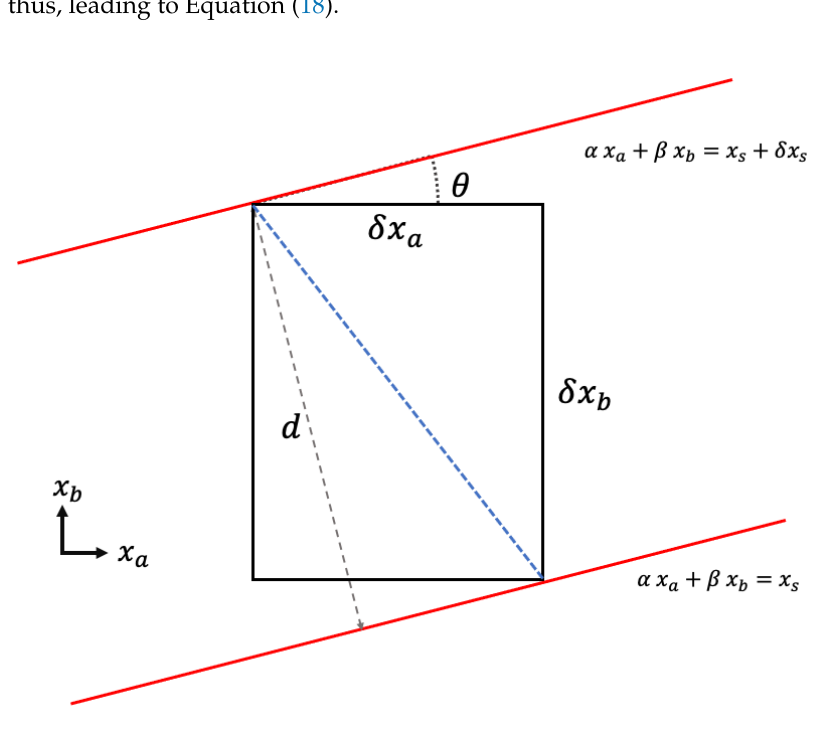
Figure A1. Minimum separation between two details. See text for